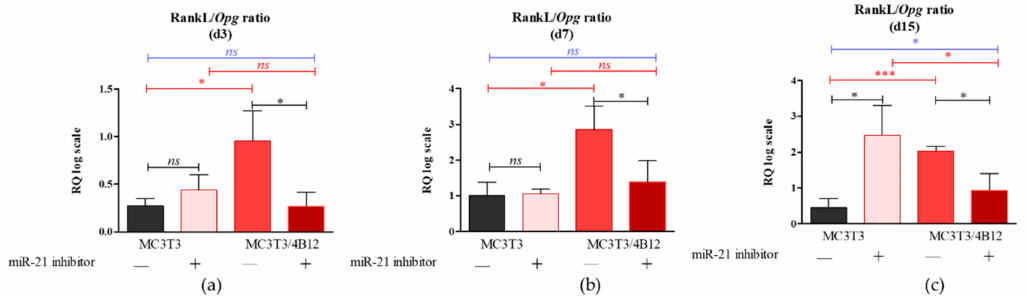
Figure 2. The Rankl / Opg ratio determined in experimental osteogenic cultures on days 3 ( a ), 7 ( b ), and 15 ( c ). Significant di ff erences are indicated with asterisks (* p < 0.05 and *** p < 0.001), while non-significant di ff erences are marked as ns . The comparisons between groups are marked with square